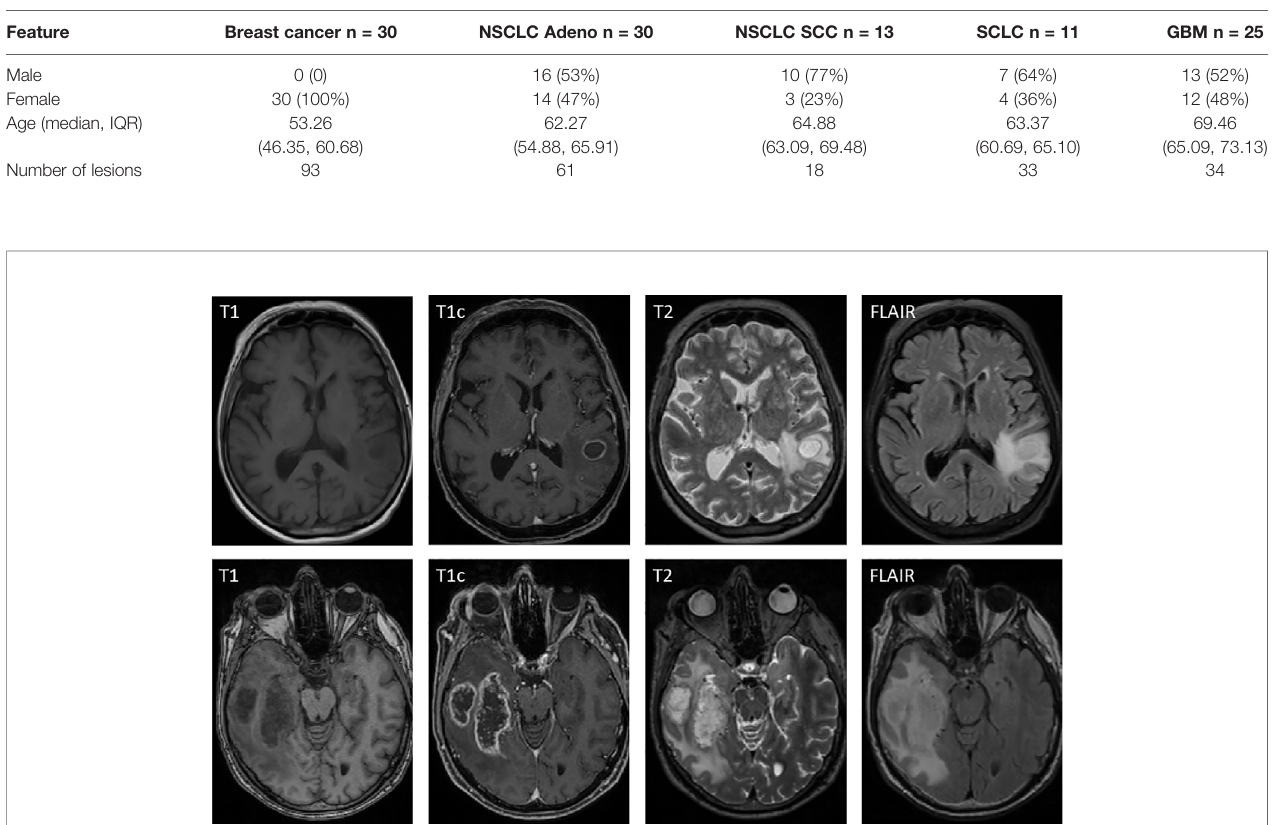
FIGURE 2 | Exemplary case of a solitary brain metastasis from a NSCLC adenocarcinoma (top row) shown alongside an exemplary glioblastoma case (bottom row). In both cases, contrast-enhancing tumor, central necrosis, and peritumoral edema are